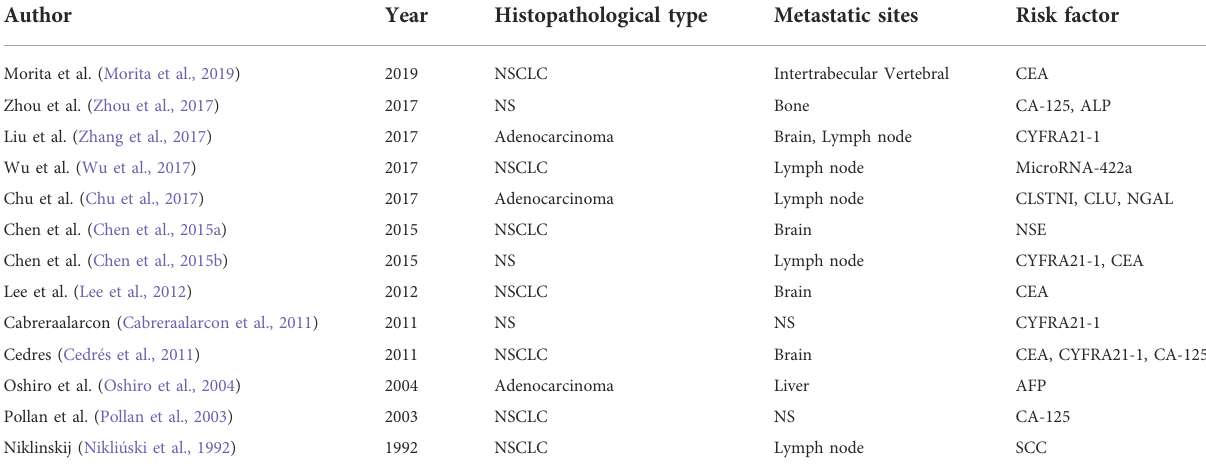
TABLE 5 The risk factors of metastases of lung